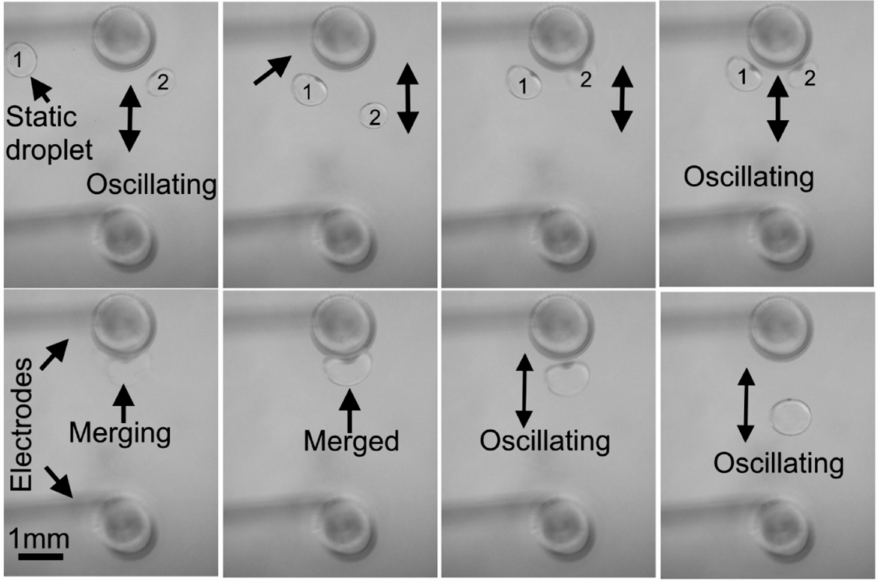
Figure 6. Sequential images of two droplets merging using electrical tweezers under the influence of applied potential of 560 volts (V/d = 140 V/mm) at 2